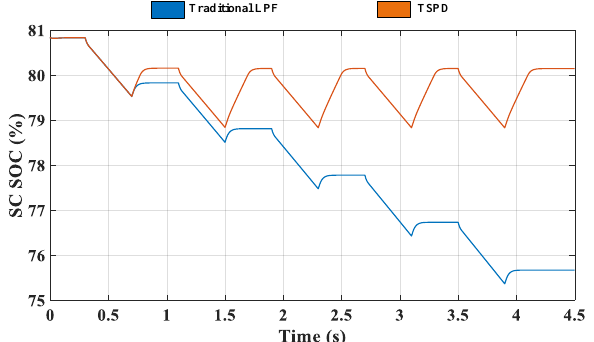
Figure 11. Simulation of Super Capacitor SOC Automatic Recovery Strategy.